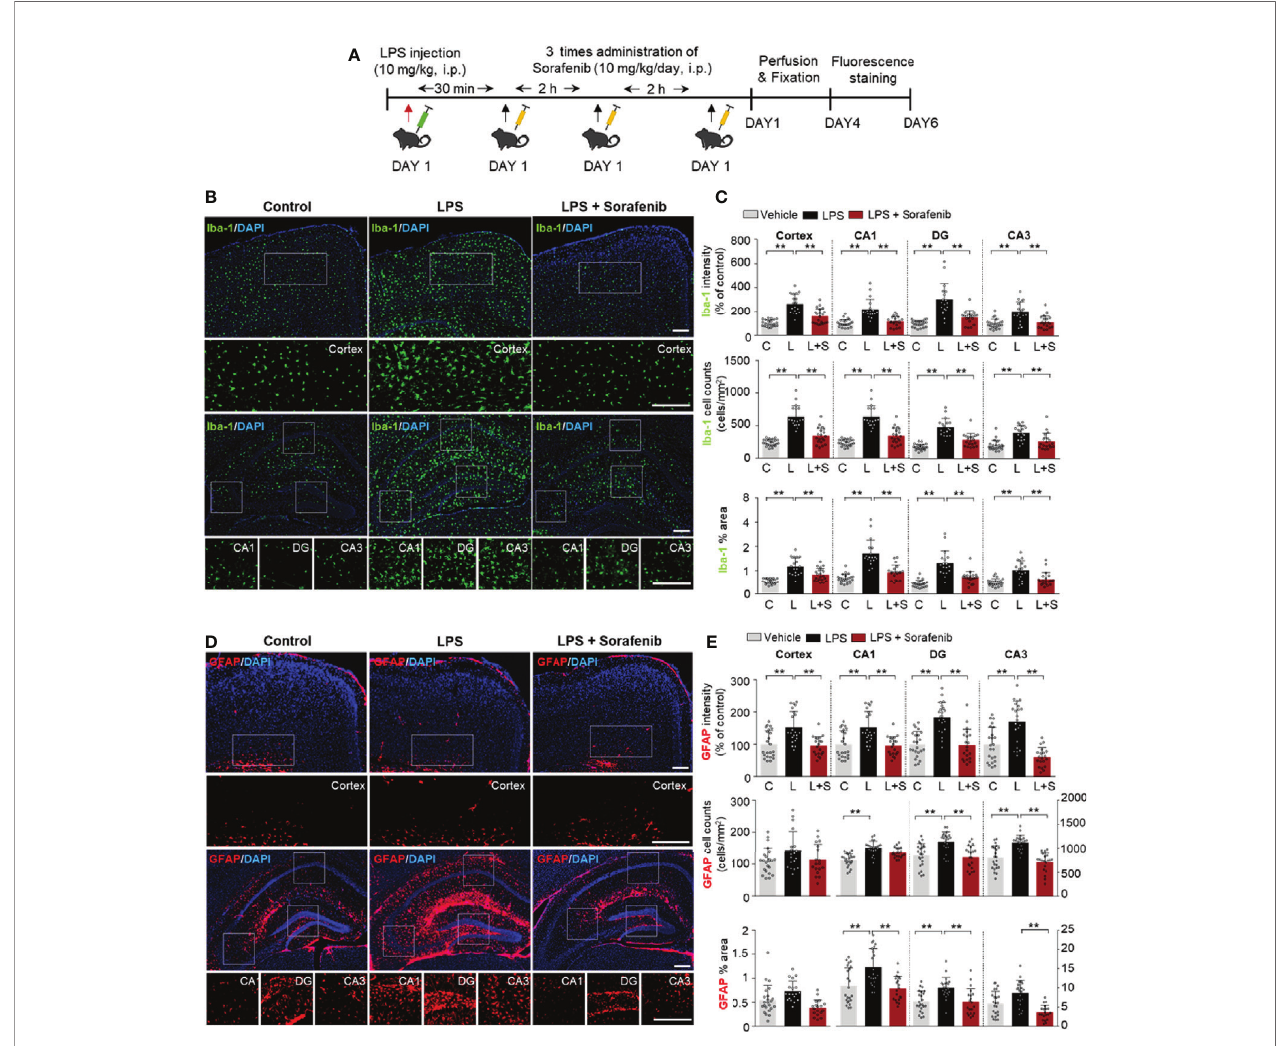
FIGURE 6 | Posttreatment of sorafenib inhibits LPS-induced microgliosis and astrogliosis in wild-type mice. (A) Scheme for the treatment of wild-type mice with LPS followed by sorafenib. (B, D) Immuno fl uorescence staining with anti-Iba-1 and anti-GFAP antibodies of brain slices from wild-type mice treated as described in (A) . (C, E) Quanti fi cation of the data in (B, D) (analyzed number of brain slices/images (n); Iba-1: Vehicle, n=21; LPS, n=23; LPS + Sorafenib, n=18, GFAP, Vehicle, n=23; LPS, n=22; LPS + Sorafenib, n=20). **p < 0.01. Scale bar = 200 m